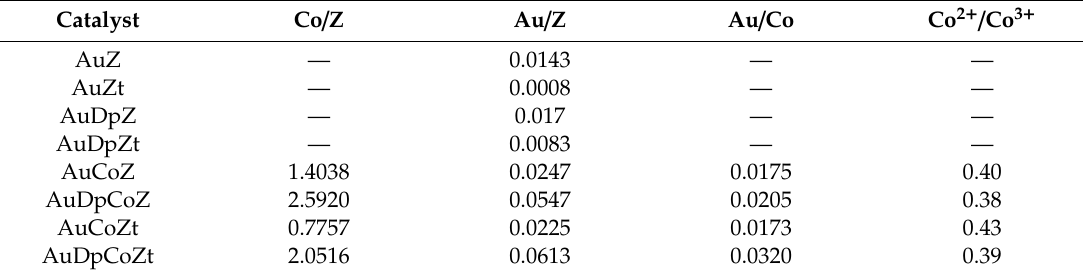
Table 3. XPS results: atomic ratios of catalysts.